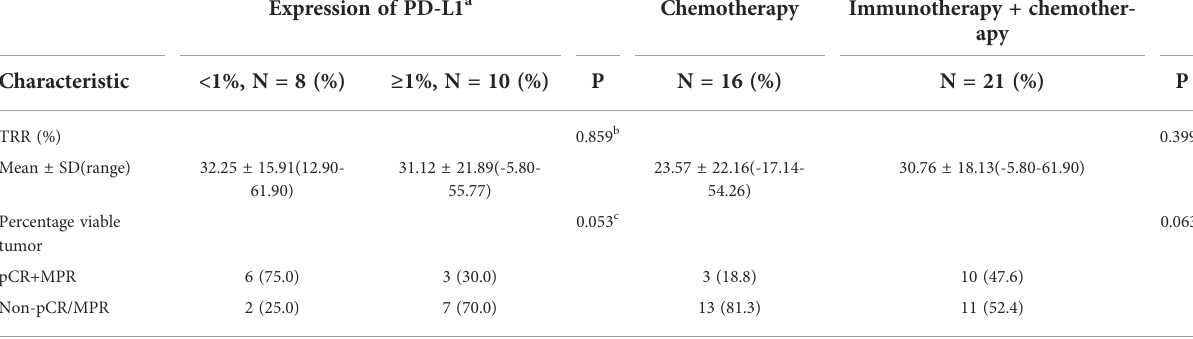
TABLE 5 The results in different groups of PD-L1 expression and treatments. Expression of PD-L1 a